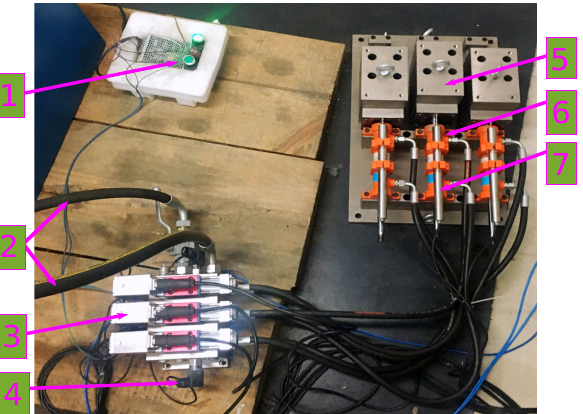
Figure 8. The experimental platform of EHS: 1—Pressure switch, 2—Power supply, 3—Servo valve, 4—Pressure transducer, 5—Mass, 6—Cylinders, and 7—Position transducer.